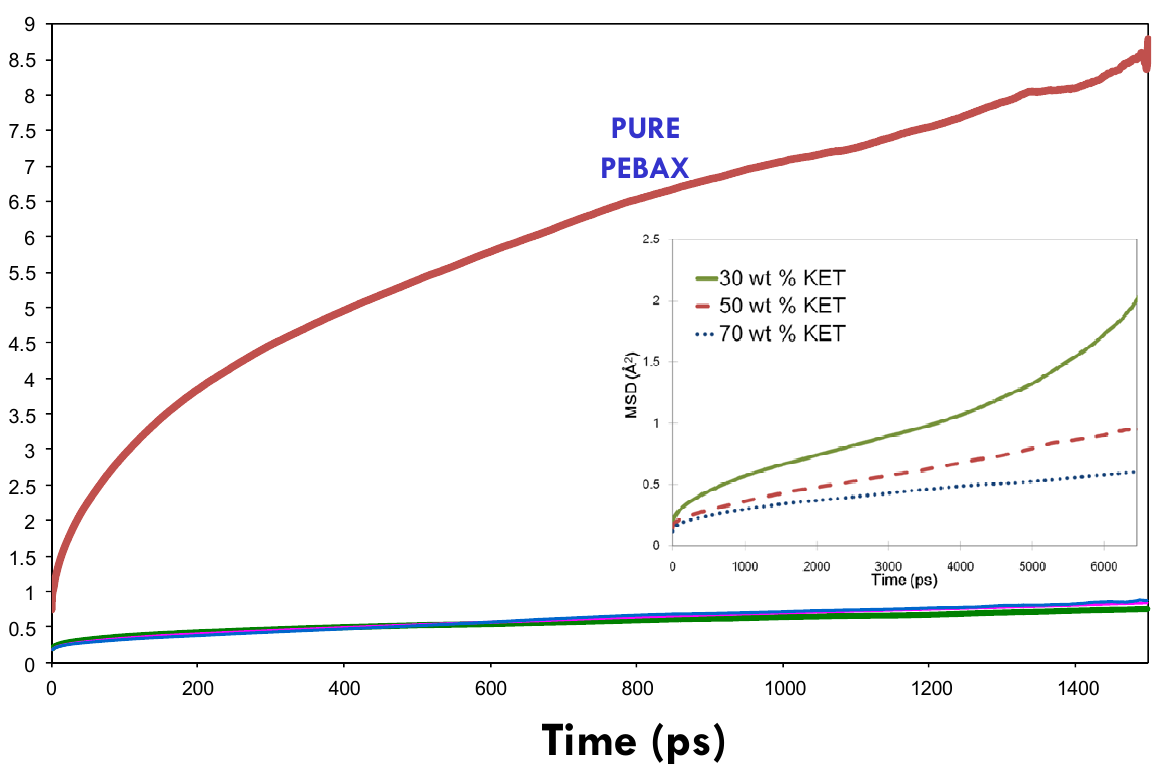
Figure 2. Polymer chain mean squared displacements curves (MSD) in pure PEBAX (time = 1.5 ns) and PEBAX/KET models (time = 7